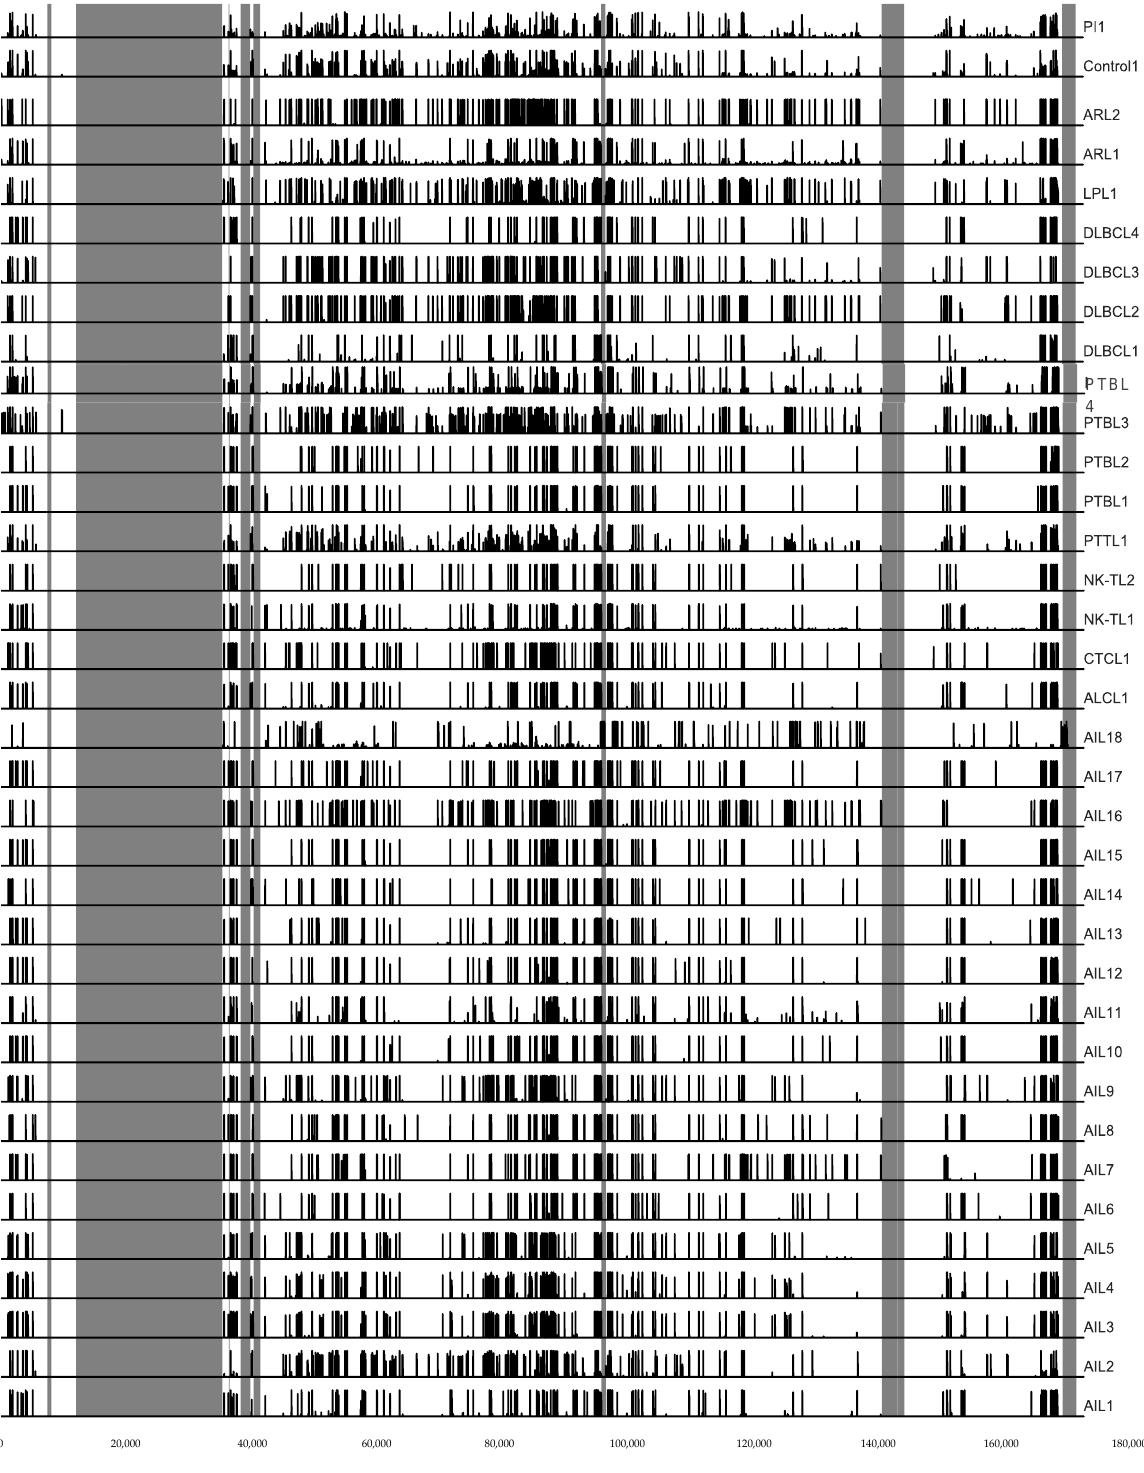
Figure 2. Genetic variations among the genome for the different viral strains compared to the reference. Regions shaded in gray correspond to internal and terminal repeats.